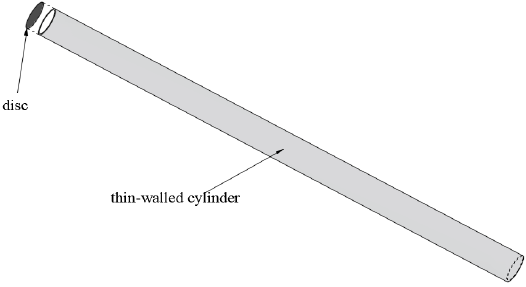
Figure 7. The velocity field of the anchorage segment region: ( a ) profile diagram, ( b ) cross-sectional diagram.